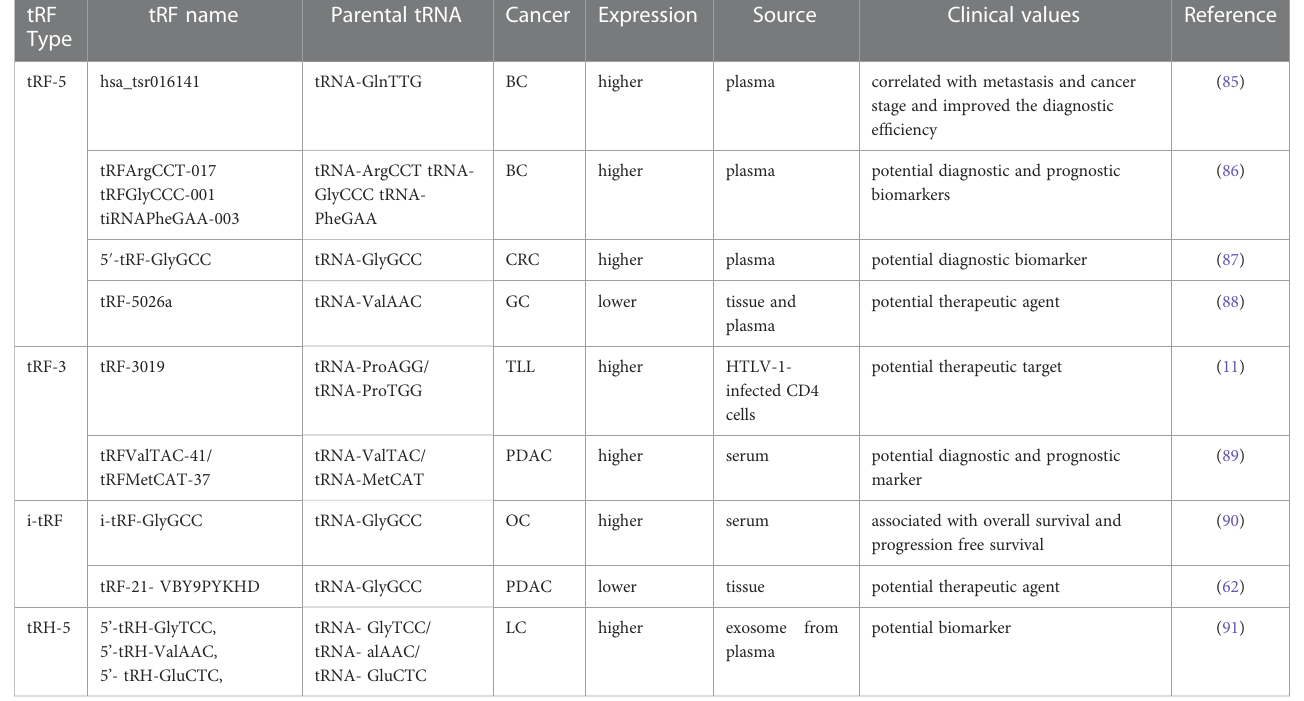
TABLE 1 Clinical values of tRFs in various